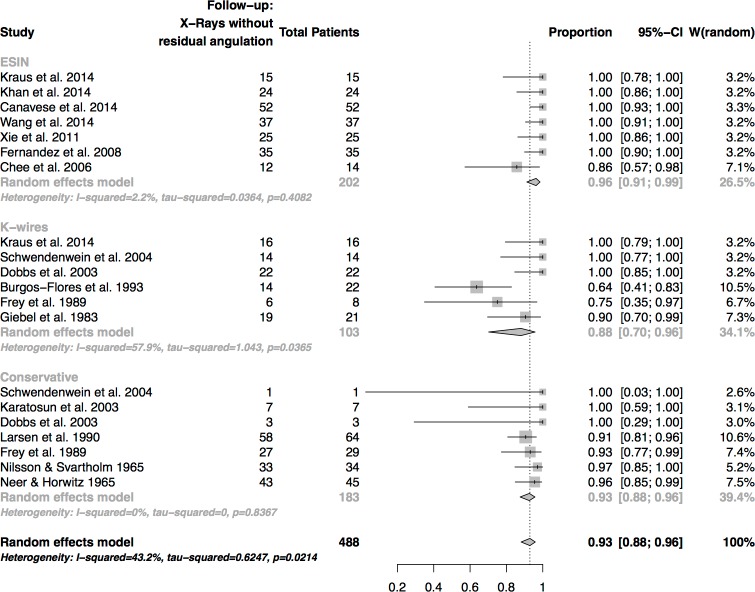
Analysis of X-Rays at final follow-up.Only X-rays without residual deformity were weighted as a successful treatment.